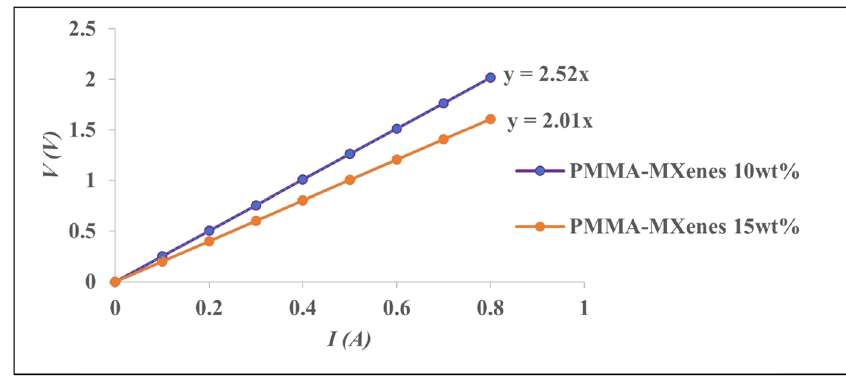
Figure 12: Voltage – current ( V – I ) graphs for samples at room